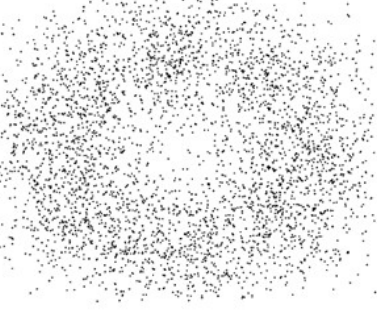
Figure 5. 8PSK (SNR = 6 dB). Figure 5. 8PSK ( SNR = 6 dB)